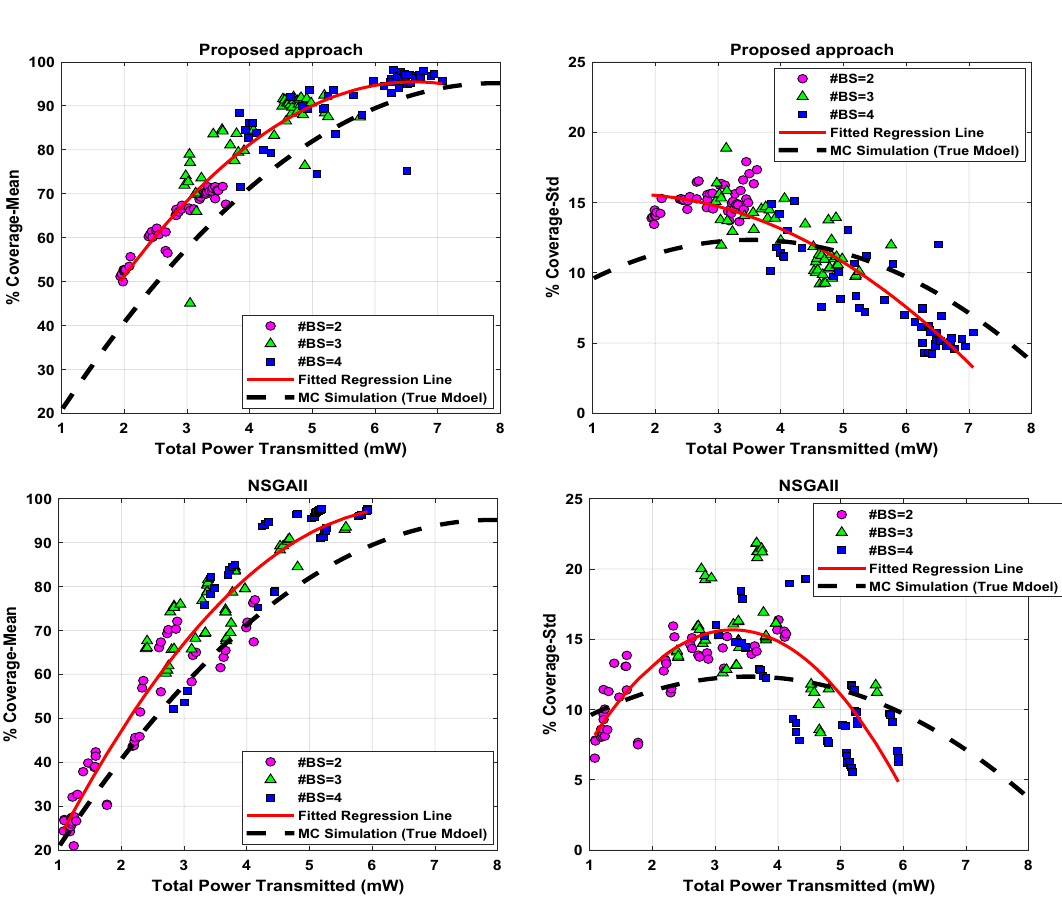
Figure 8. The estimation of the Pareto front using the proposed approach and NSGAII method for the mean and standard deviation of the coverage versus the transmitted total power. The estimation is obtained regarding different values of the weighting parameter α